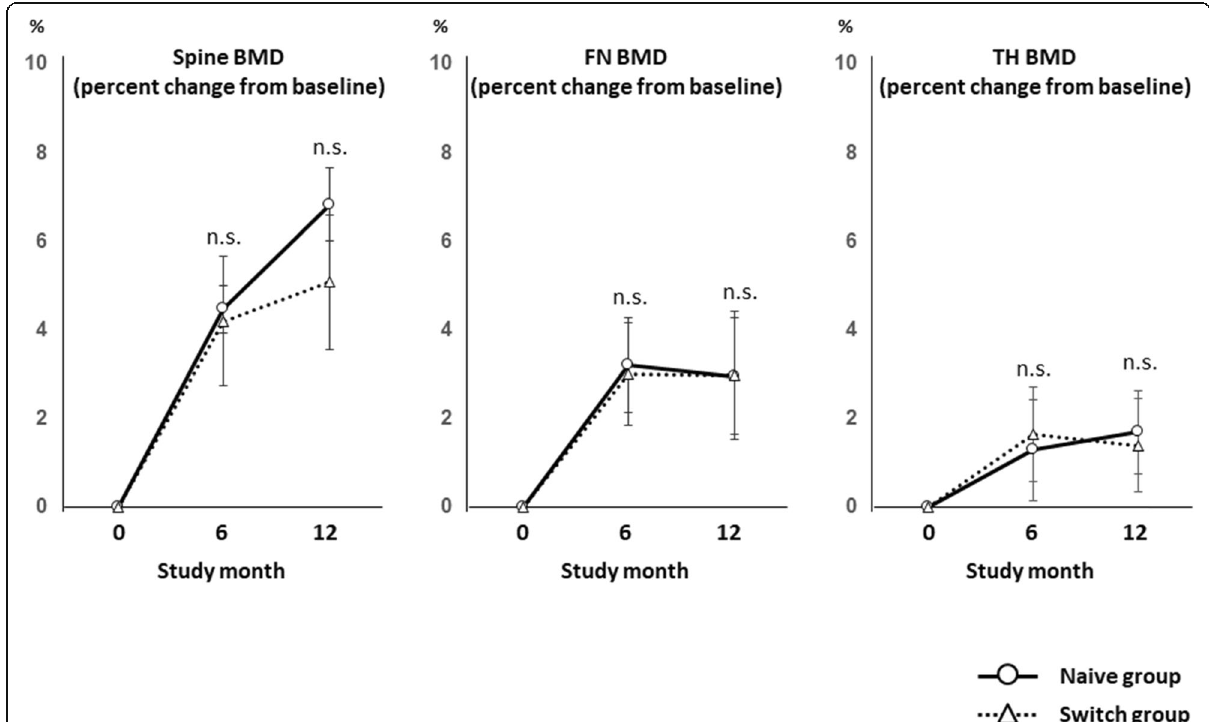
Fig. 2 Mean percent changes from baseline in lumbar spine and hip BMDs. Naive group: treatment-naïve group; switch group: transitioning from bisphosphonate group; BMD: bone mineral density; FN: femoral neck; TH: total hip. P values from Mann-Whitney U tests, for the mean percent change from baseline in the naive group versus the switch group. n.s denotes no significant difference between the